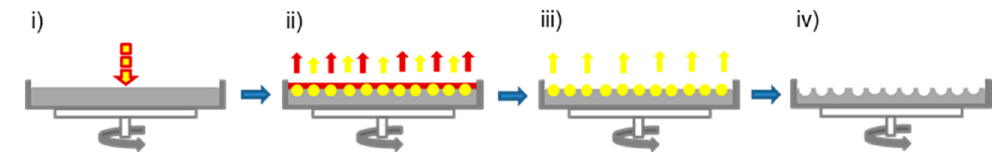
Figure 1. Principle of polymer surface texturization using phase separation associated with different evaporation rates of good and bad solvents at the rotation. ( i ) dosing of tetrahydrofuran (THF) with 2-ethoxyethanol (ETH) or water (H 2 O) on the polystyrene (PS) Petri dish; ( ii ) swelling and dissolving of polymer surface by good solvent (THF) and separation of poor solvent (ETH or H 2 O) into microdroplets; ( iii ) rapid evaporation of THF while the ETH or H 2 O droplets are embossed into the surface creating a template for the resulting structure; ( iv ) resulting structured PS surface.